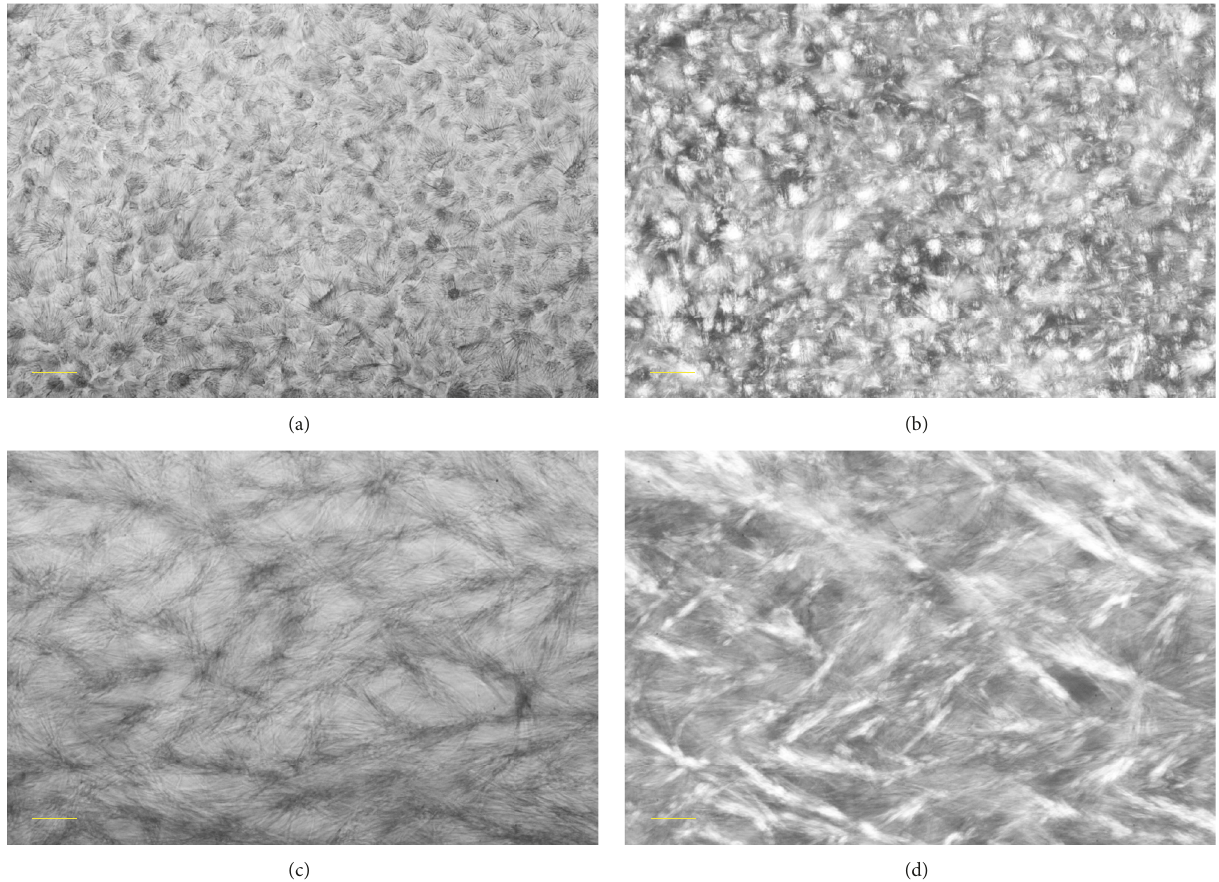
Figure 1: Optical (a, c) and polarizing optical (b, d) images of 3 wt% 12-HSA/[ABIm][TFSI] gel prepared by quench to room temperature (a, b), and at a cooling rate of 0.4 ∘ C/min (c, d). The scale bar in the figure is 100 𝜇 m.